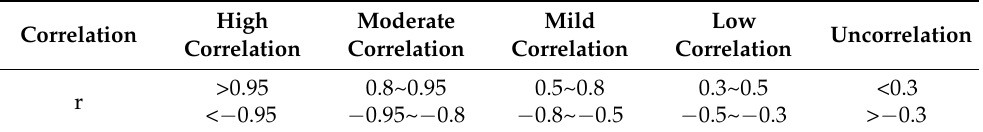
Table 10. The correlation levels of